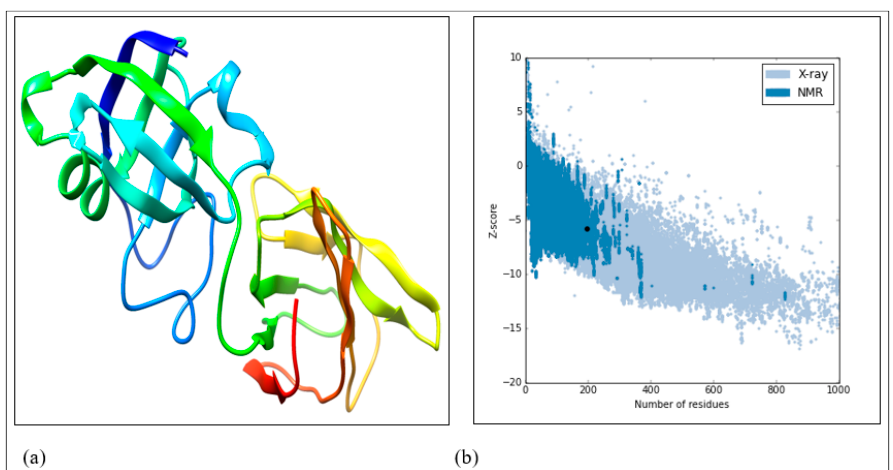
Figure 5. ( a ) Energy minimized structure with ( b ) its Z-score plot for model 2.